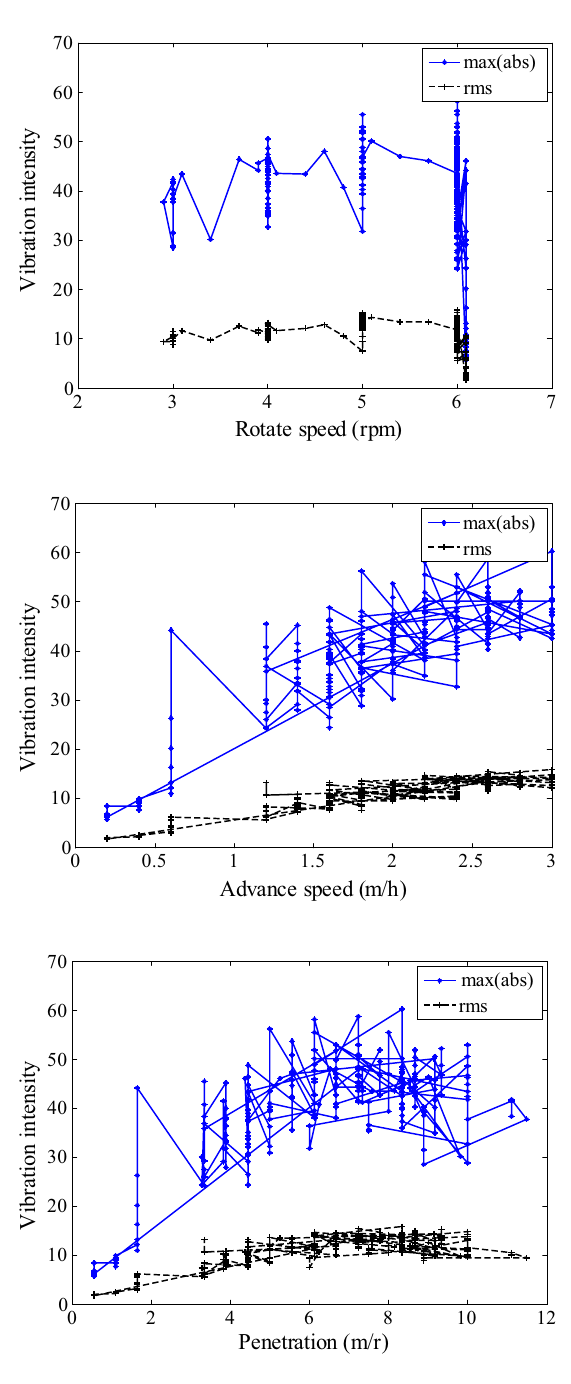
Figure 6. Relationship between penetration and vibration